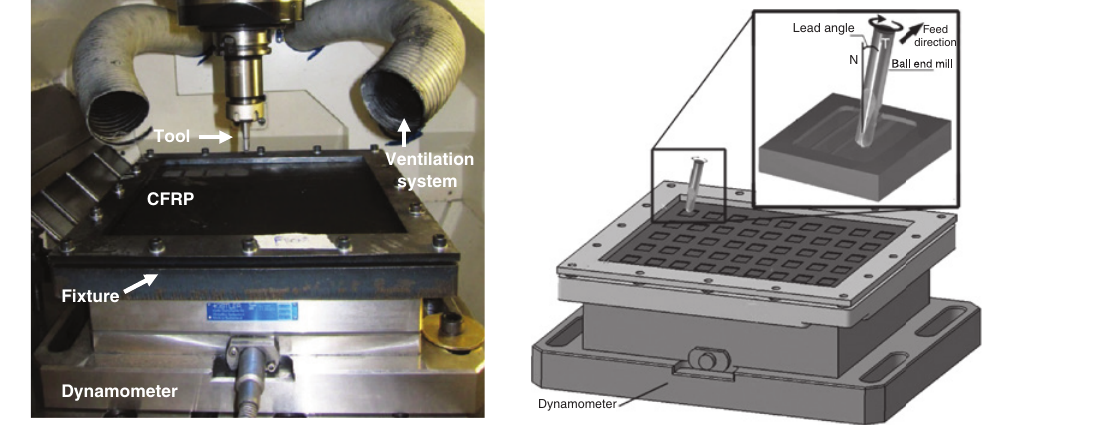
Figure 1: Experimental setup for the machining of